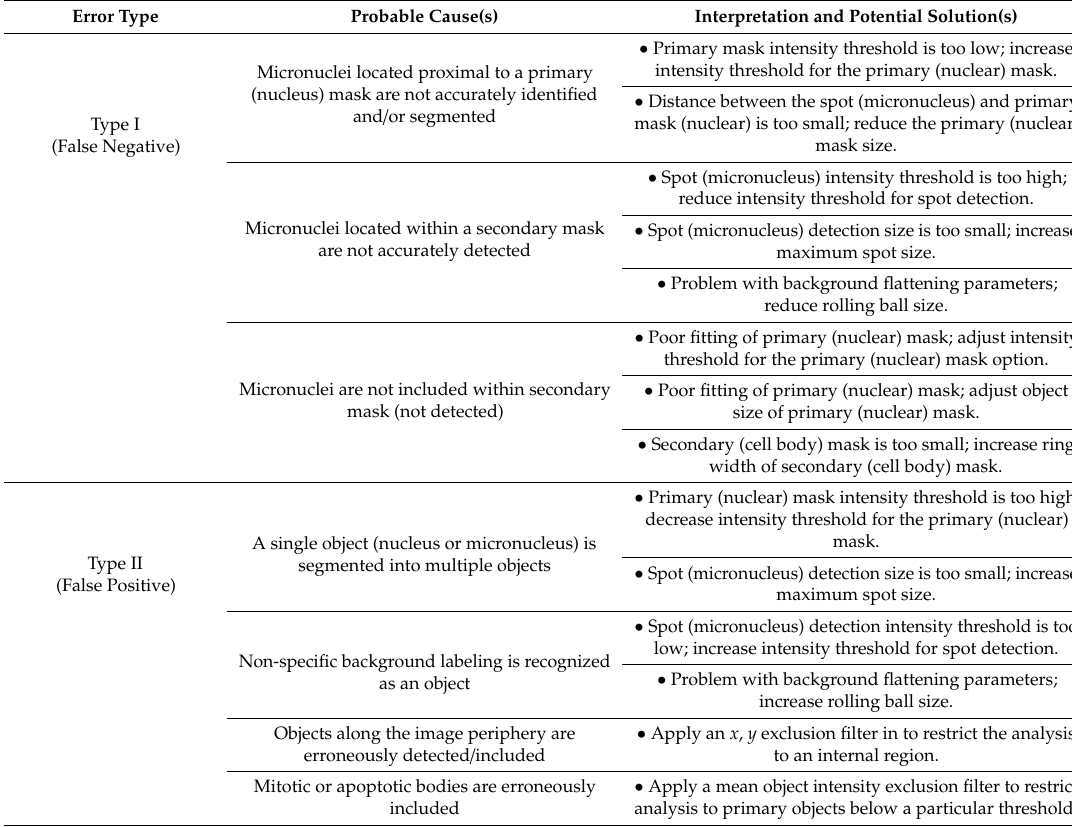
Table 2. Troubleshooting for common types of spot detection